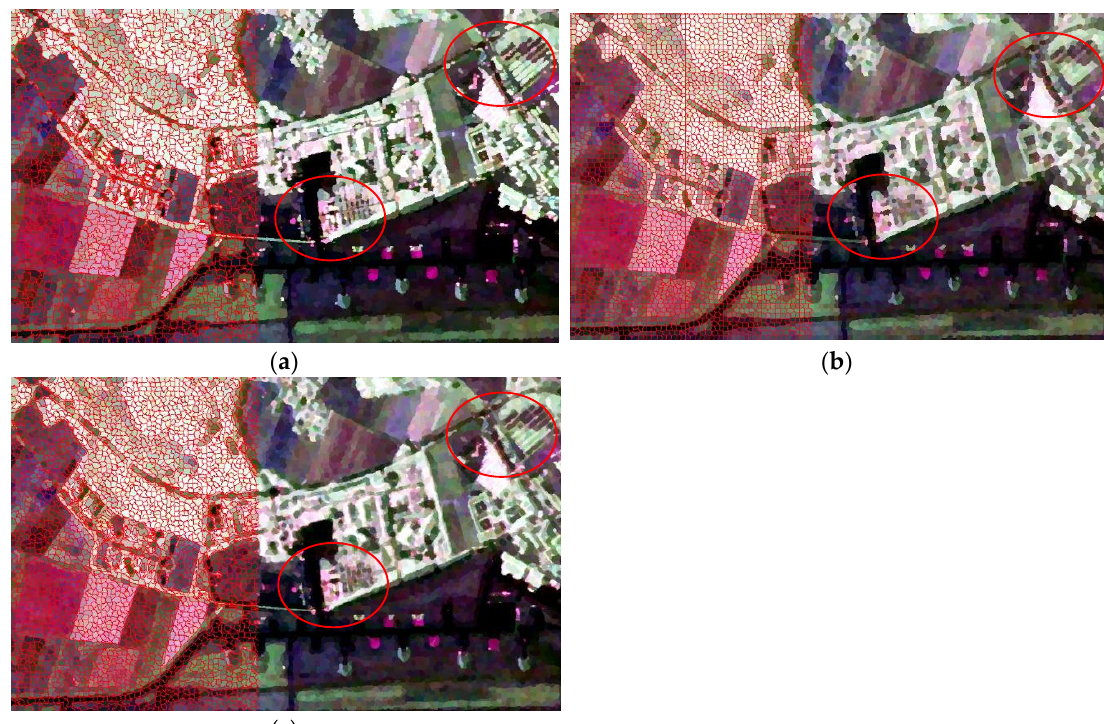
Figure 8. The superpixel segmentation results that were obtained with the ESAR PolSAR image: ( a ) GMS segmentation, with N r = 7449; ( b ) Ncut segmentation, with N r = 8064; and, ( c ) SLIC-GC segmentation, with N r = 7728.